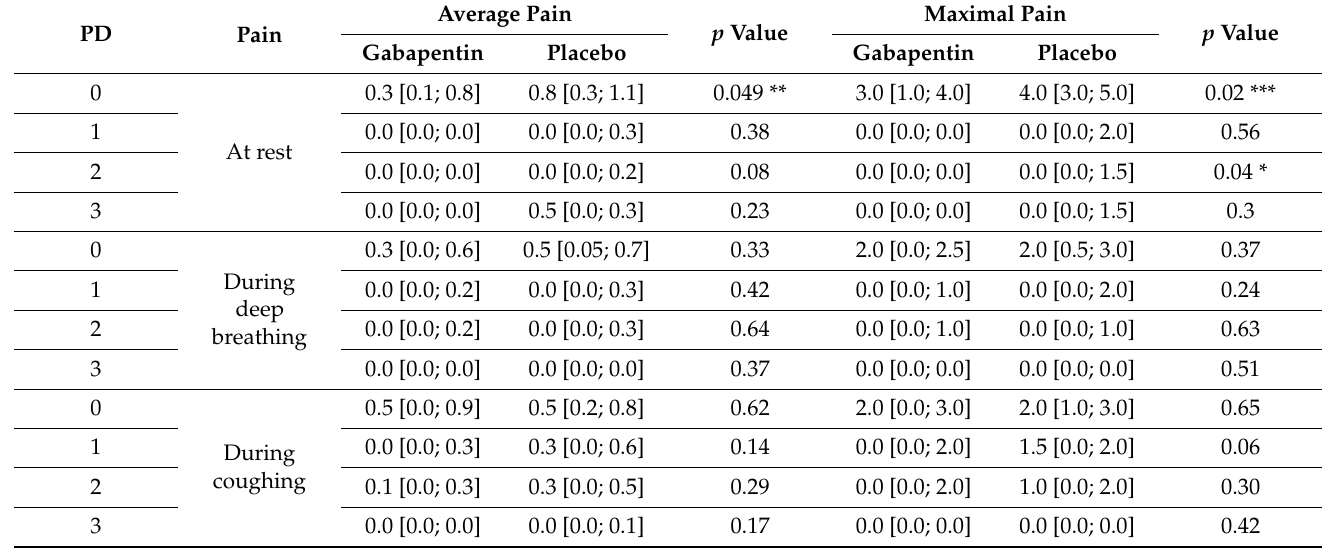
Table 2. Postoperative pain scores at rest, during deep breathing and coughing according to NRS in the gabapentin group ( n = 28) and the placebo group ( n = 28).